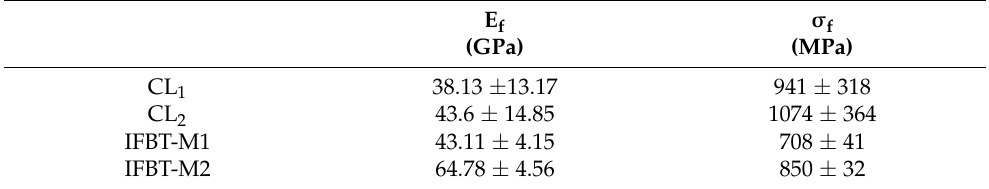
Table 5. Tensile properties of CL fibers. Comparison between experimental and predicted values.